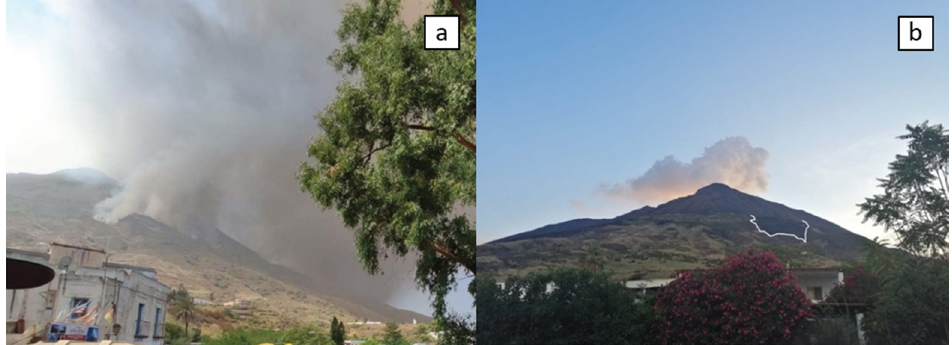
Figure 10. ( a ) wildfire near Stromboli village and ( b ) fire damages, following the 28 th August 2019 paroxysmal explosion.